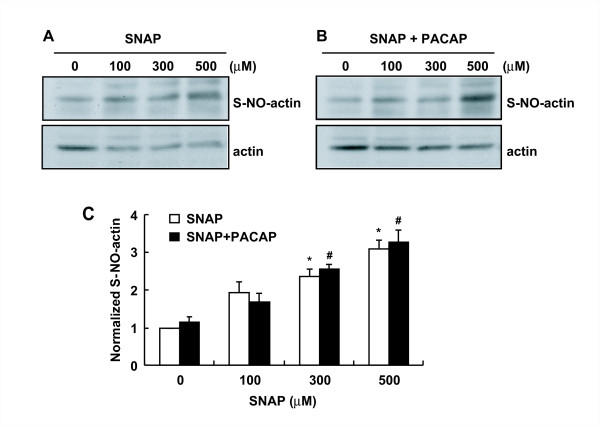
S-Nitrosylation of actin by SNAP in PC12 cells. A, B. S-Nitrosylation of actin in PC12 cells by SNAP in the absence (A) and presence (B) of PACAP. PC12 cells (7 × 105 cells/dish) cultured in 6-cm dishes were exposed to 100, 300 or 500 μM SNAP with 10 nM PACAP for 5 min. The cell lysates in HEN buffer were subjected to the biotin-switch assay and analyzed by SDS-PAGE as described in "Methods." C. Quantification of S-nitrosylated actin in PC12 cells. Intensity of bands was quantified by ImageJ, and the extent of S-nitrosylated actin was normalized to total actin. S-Nitrosylated actin by SNAP in the absence (A, open columns) and presence (B, closed columns) of PACAP is expressed as a ratio (mean ± SEM, n = 3) to that at 0 μM SNAP. *P < 0.05 vs.0 μM SNAP without PACAP; #P < 0.05 vs.0 μM SNAP with PACAP.